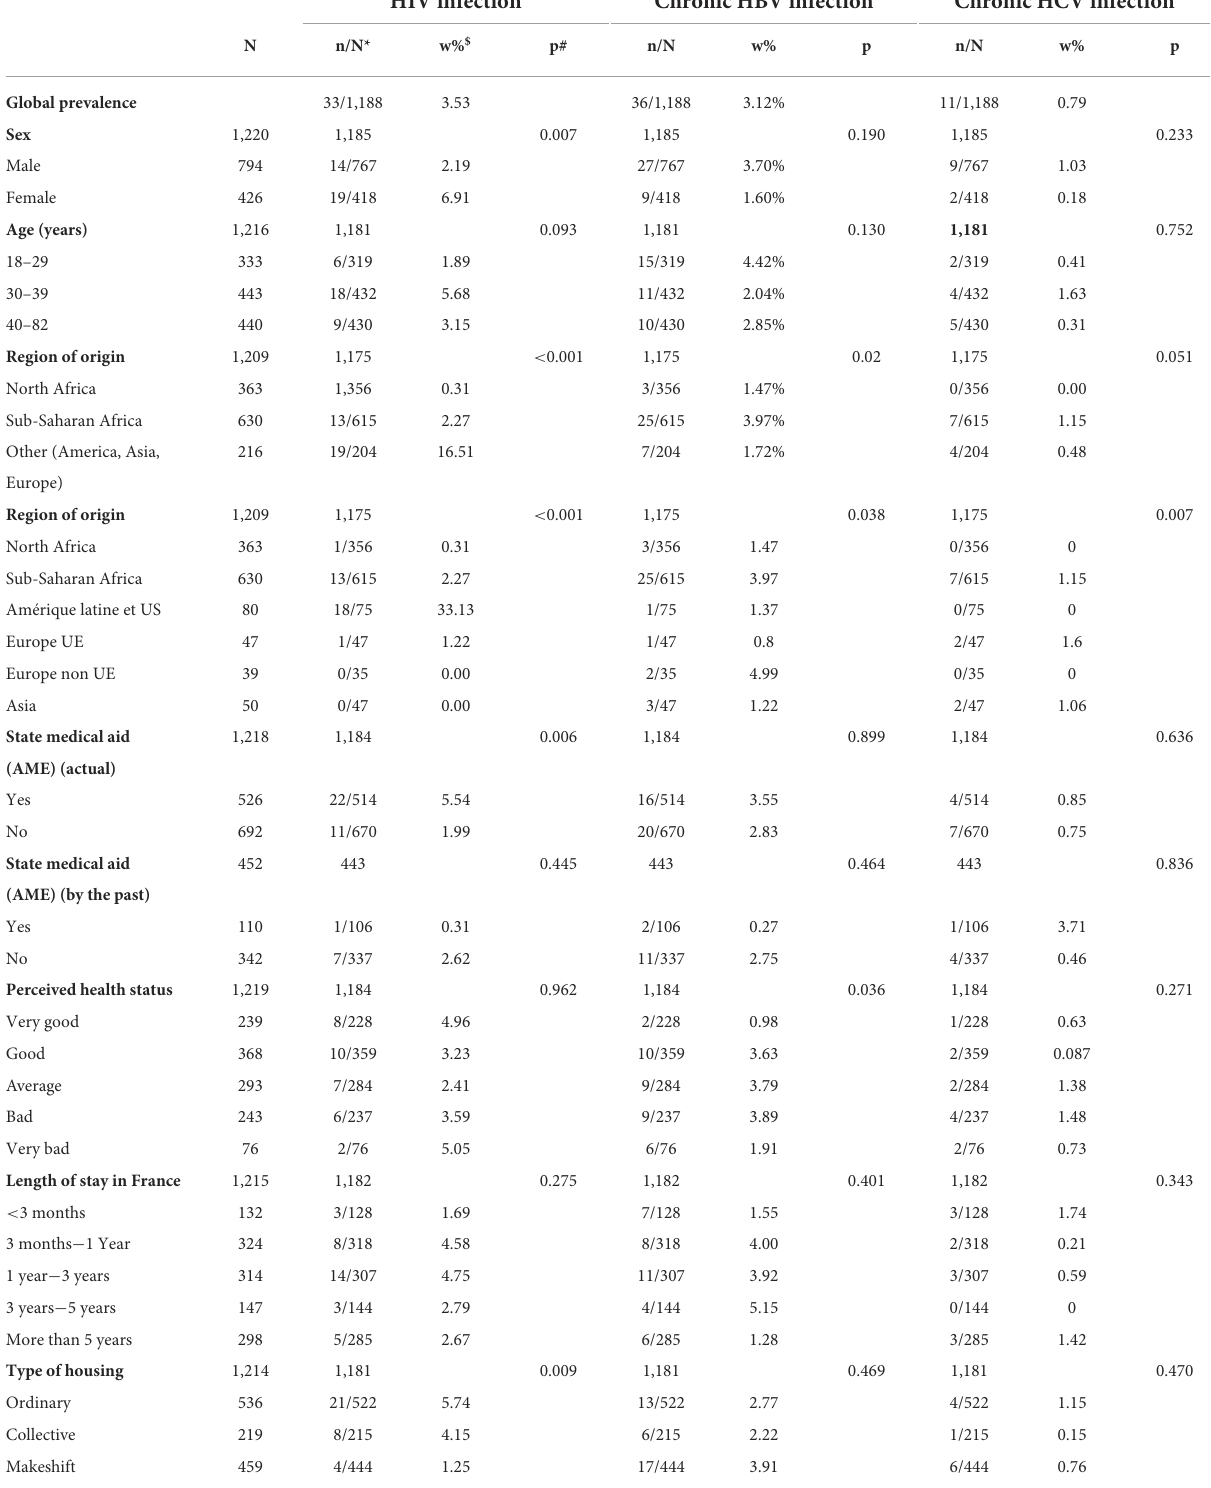
TABLE 2 Reported prevalence of chronic viral infections (HIV, HBV, or HCV infection) among undocumented migrants in Paris and Bordeaux according to sociodemographic characteristics, Premiers Pas survey ( n = 1.167). HIV infection Chronic HBV infection Chronic HCV